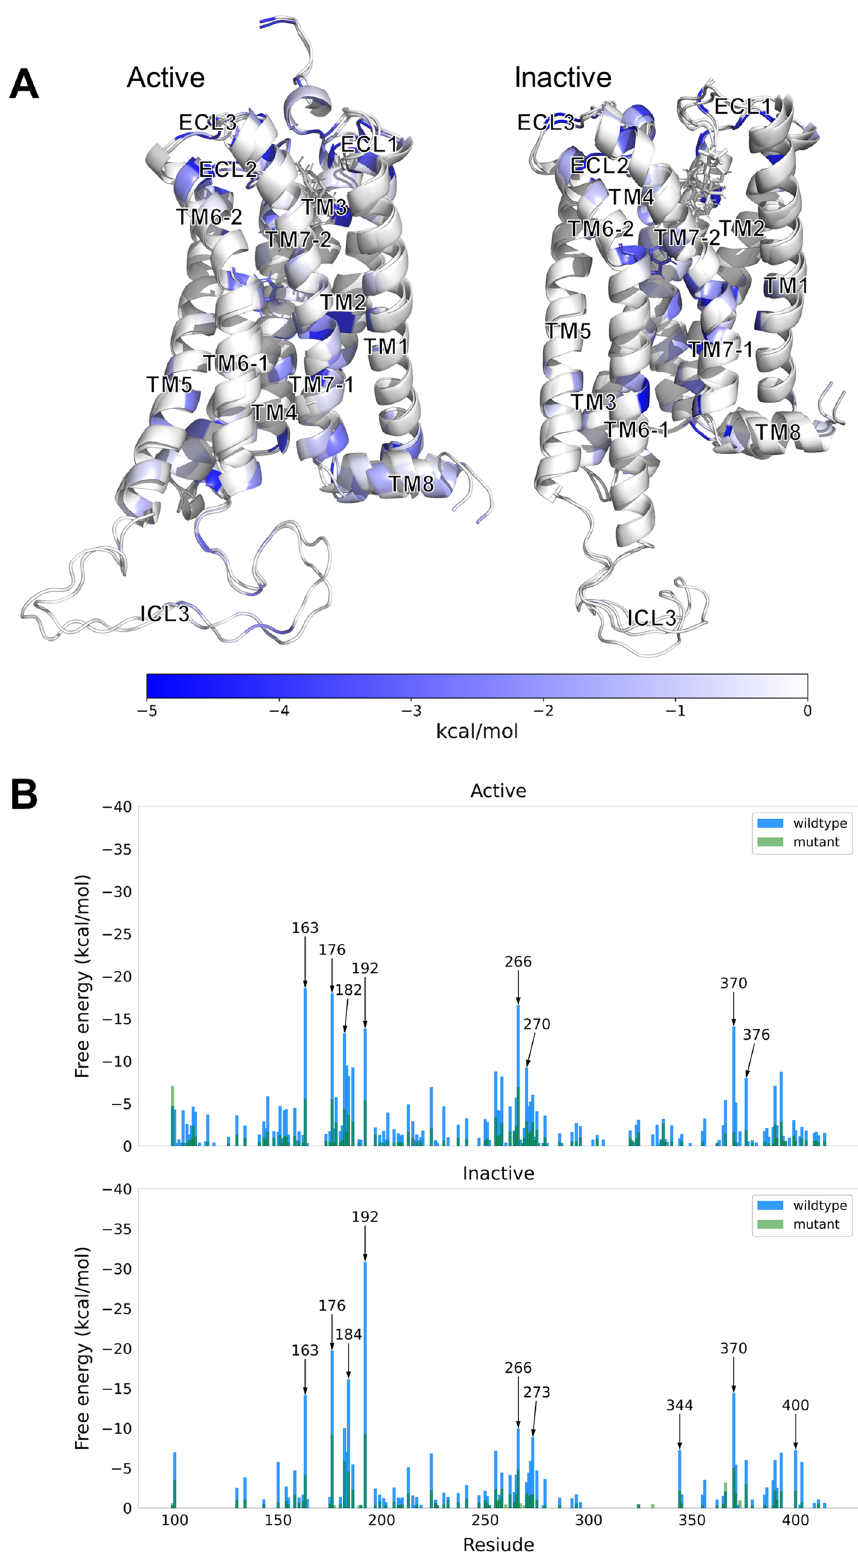
Figure 5. The comparison of residual interaction energies between wildtype and mutant CB1. ( A ) For each activation state, all residues are colored as blue according to their residual interaction energies. The CB1 structures are used the structures after energy minimization. ( B ) The significant residues between wildtype (blue) and mutant (green) for each activation